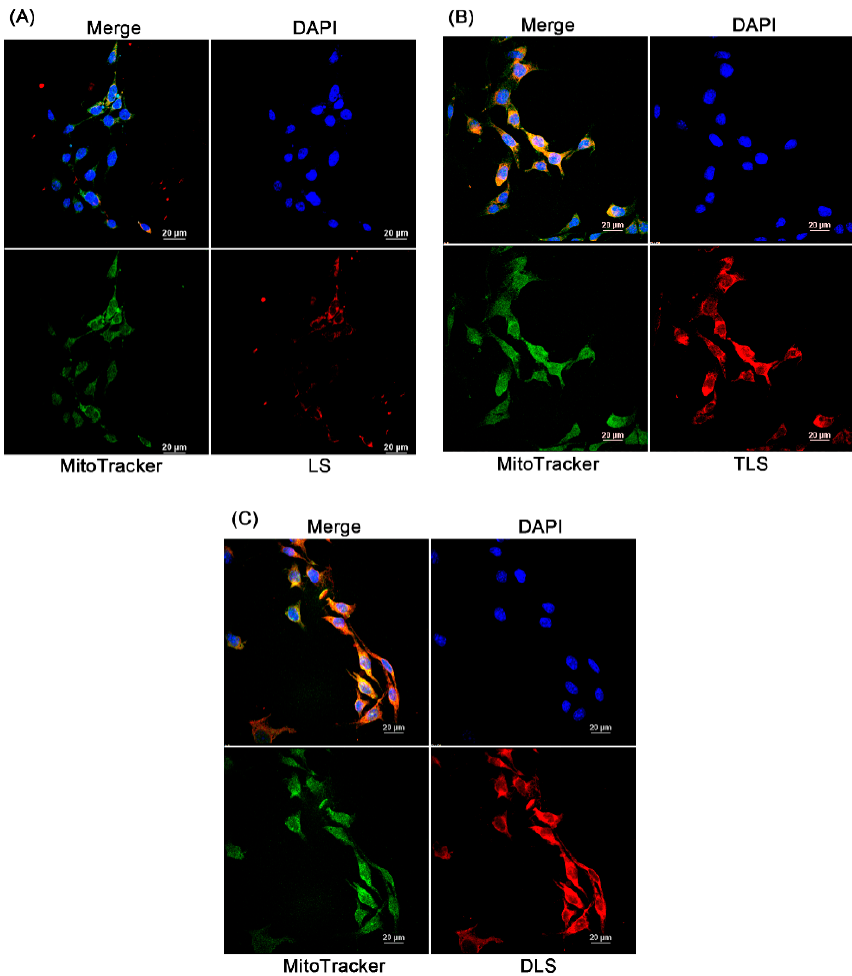
Figure 7. Cellular uptake of the non-targeting liposomes without resveratrol (LS) and mitochondrial- targeting liposomes without resveratrol (TLS and DLS) in B16F10 cells. Laser scanning confocal microscopy (LSCM) images after a 1 h of incubation with LS ( A ), TLS ( B ) and DLS, and ( C ) red, rhodamine-labeled liposome; green, MitoTracker; blue, 4 ′ ,6-diamidino-2-phenylindole (DAPI). Furthermore, to quantify the mitochondrial accumulation of resveratrol delivered by mitochondria- targeting liposomes, mitochondrial and cytosol fractionation was performed. The amount of mitochondrial accumulation was quantified using LC–MS / MS and the percentage ratio was calculated based on total uptake amount of resveratrol in each treated group. At 1 h post-incubation, significantly higher concentrations of resveratrol were found in the cells treated with TLS (Res; 785.3 ± 82.7 ng / mL) and DLS (Res; 927.1 ± 101.2 ng / mL) as compared to those treated with LS (Res; 418.0 ± 31.9 ng / mL) and free resveratrol (227.5 ± 58.3 ng / mL; data not shown). As shown in Figure 8, the mitochondrial resveratrol percentage ratio of TLS (Res) and DLS (Res) was 2.4- and 3.1-fold higher than that of LS (Res) in B16F10. In addition, the mitochondrial resveratrol percentage ratio of TLS (Res) and DLS (Res) was 5.1- and 6.6-fold higher than that of free resveratrol in B16F10. These results indicate that TLS (Res) and DLS (Res) were selectively accumulated in the mitochondria by the TPP- and DQA-moieties on the surface of liposomes after internalization by the